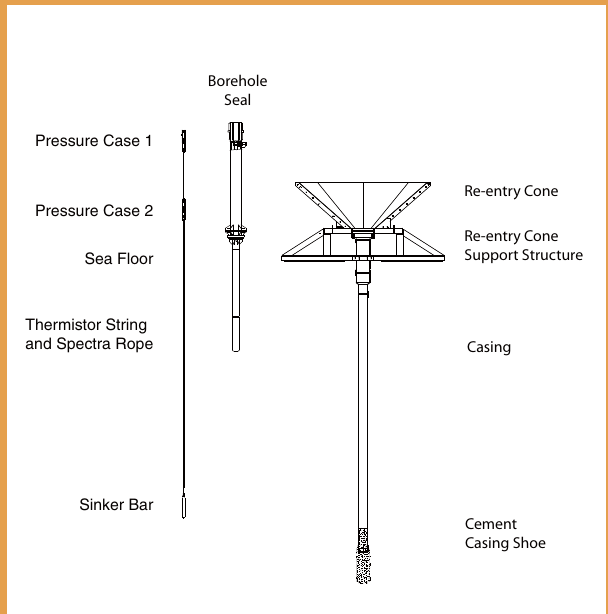
Figure 2. Experimental setup showing instrumentation, Circulation Obviation Retro fi t Kit (CORK), re-entry cone, and casing.